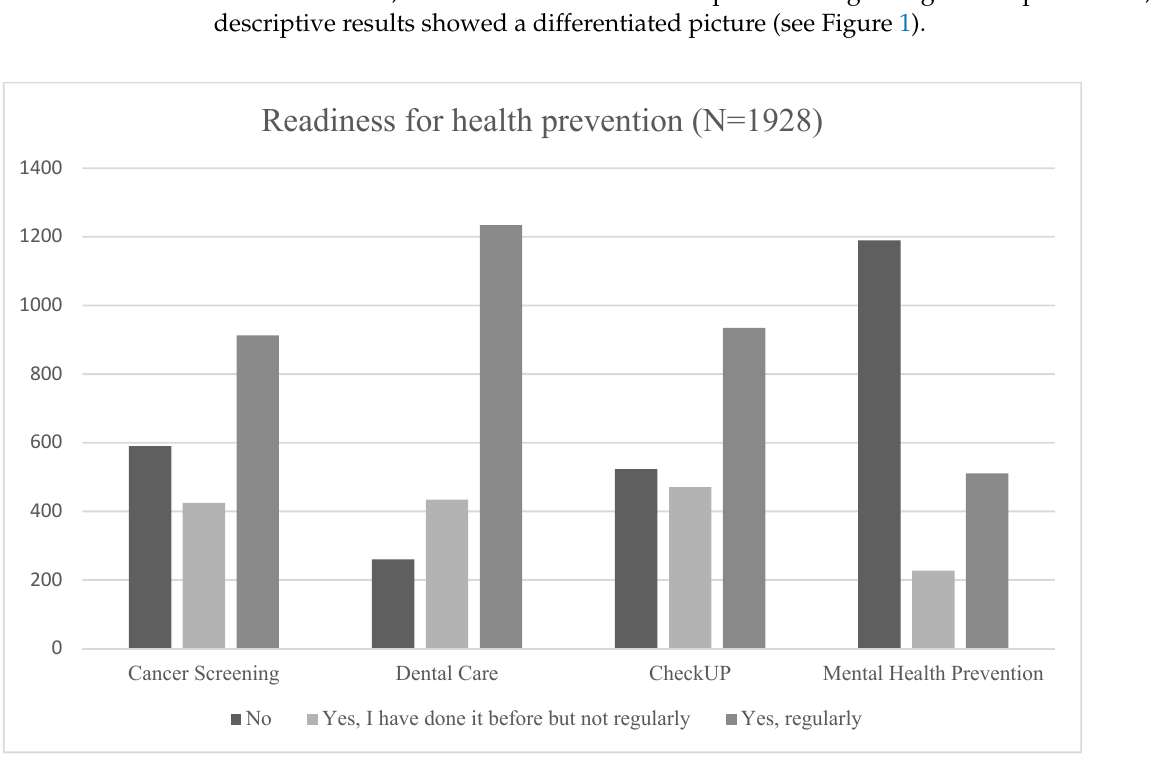
Figure 1. Readiness for health prevention in different medical fields (cancer screening, dental care and check-ups are regular precautionary offers; mental health prevention was asked as a hypothetical offer).